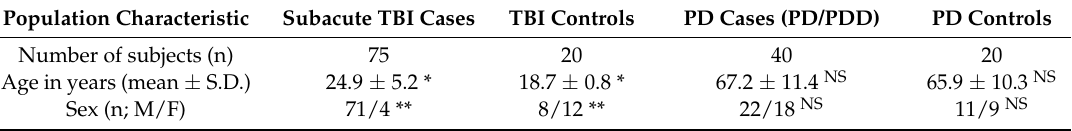
Table 1. Demographic differences of study cohorts.